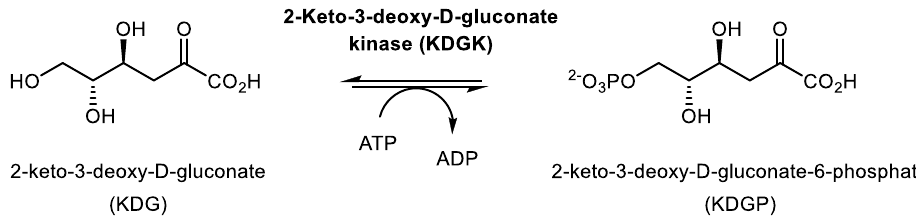
Figure 6. Reaction catalyzed by the KDGK enzymes. Table 2. Kinetic constants of the recombinant KGUK cnec .